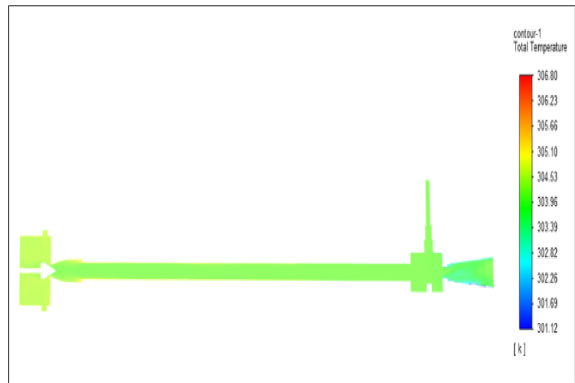
Figure 18. Copper at 4 bar.